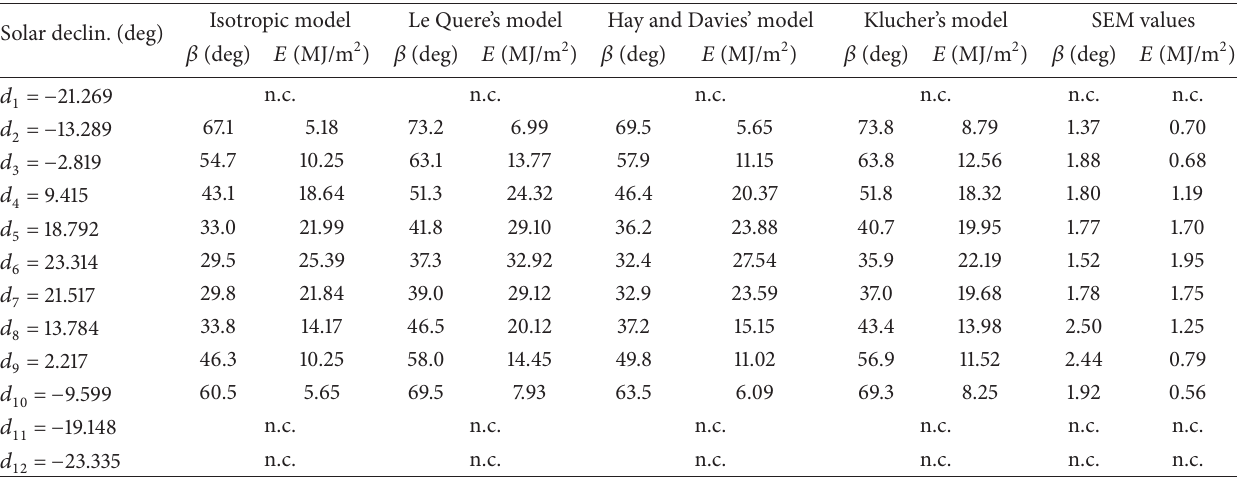
in Section 2 applied to the monthly averages of the daily global horizontal solar irradiation data acquired from 1985 to 1989 at the site of Stockholm (latitude +59 ∘ 17 󸀠 N; longitude +18 ∘ 03 󸀠 E). The monthly mean of the daily global solar radiation was not acquired in the periods relative to the solar declinations 𝑑 1 , 𝑑 11 , and 𝑑 12